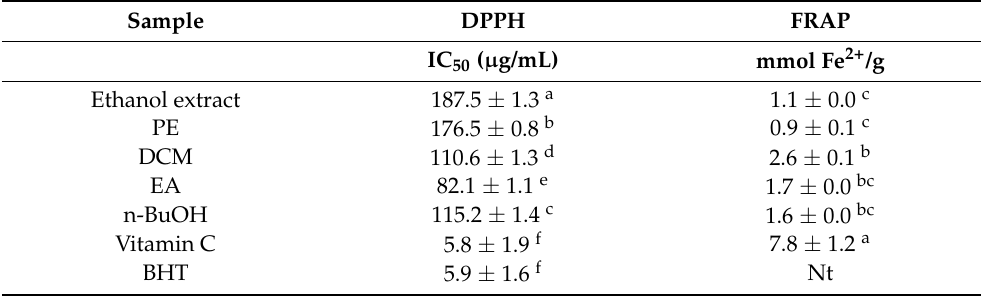
Figure 2. The radical scavenging percentage of ethanol extract and its PE (petroleum ether) fraction. DCM (dichloromethane), EA (ethyl acetate), and n-BuOH (n-butanol) of S. doederleinii by DPPH as- say. Table 1. Antioxidant activities of ethanol extract of S. doederleinii and its PE, DCM, EA, and n-BuOH fractions, and positive controls of Vitamin C and BHT evaluated by DPPH and FRAP assays.